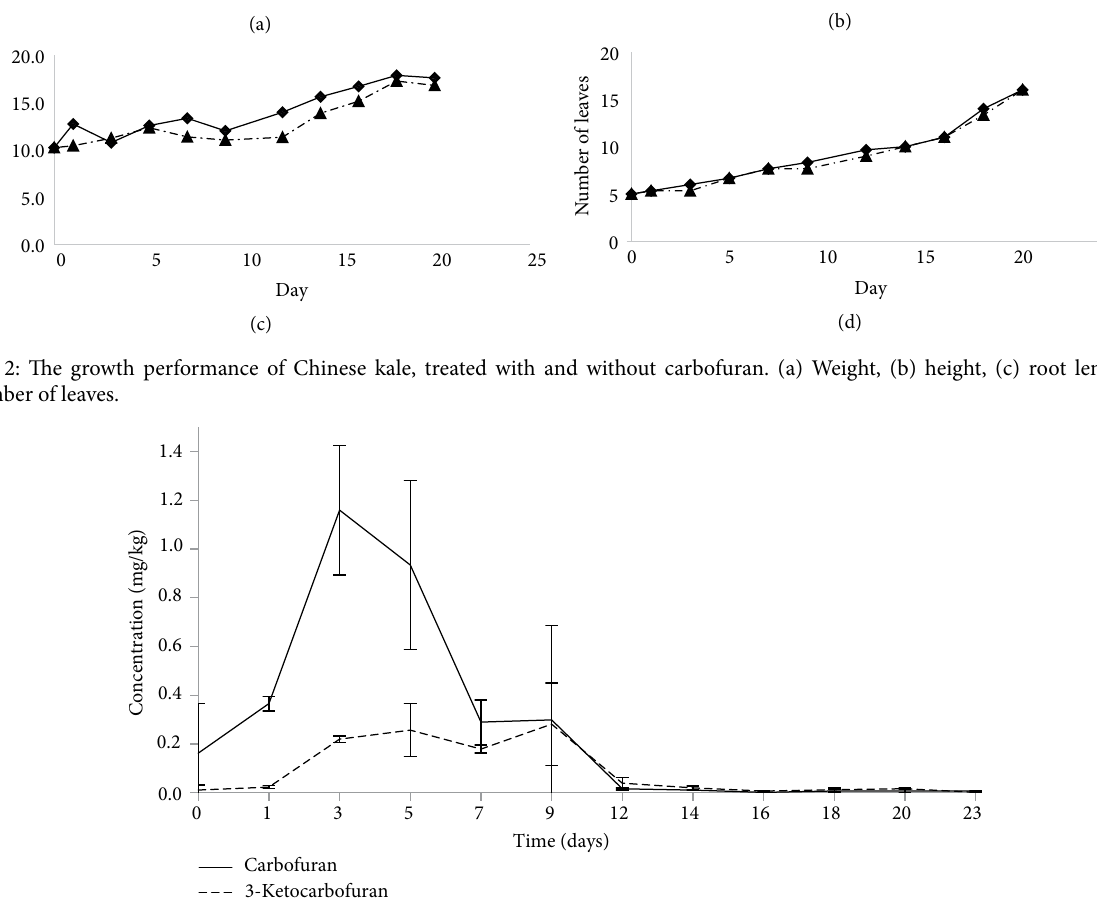
Figure 3: Carbofuran and 3-ketocarbofuran residues in Chinese kale over the experimental